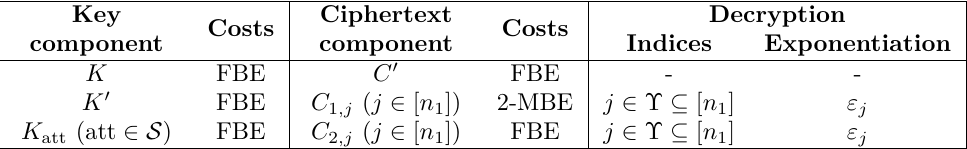
Table 2: A list of the key-ciphertext component pairs and their costs incurred in computing them during key generation and encryption, in terms of fixed-base exponentiations (FBE) and two-base exponentiations (2-MBE). For the decryption costs, we list whether the pairing is indexed and whether it needs to be